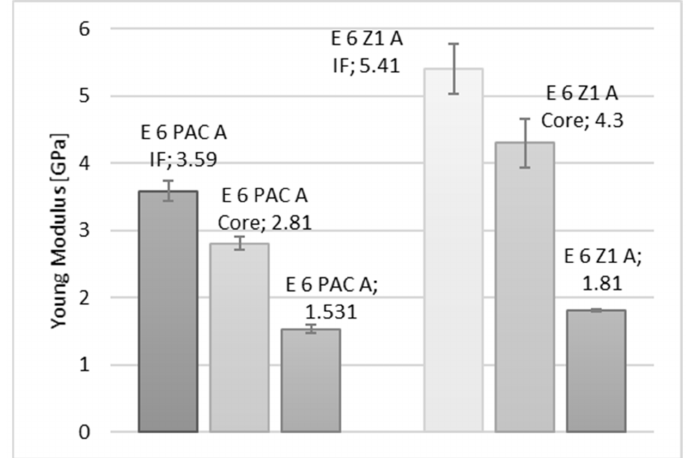
Figure 12. Comparison of the values of the Young’s modulus of an Epidian 6/PAC, Epidian 6/Z1 adhesive joint, respectively, for a joint in the wall-adjacent zone—IF, the core—Core, and for the adhesive